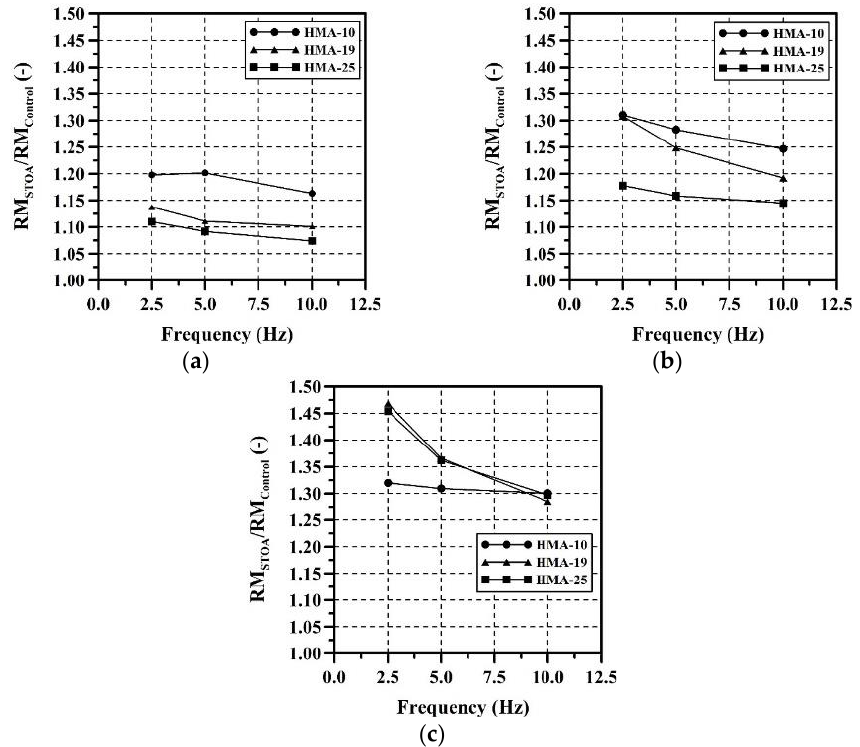
◦ C, ( b ) 20 ◦ C, and ( c ) 30 ◦